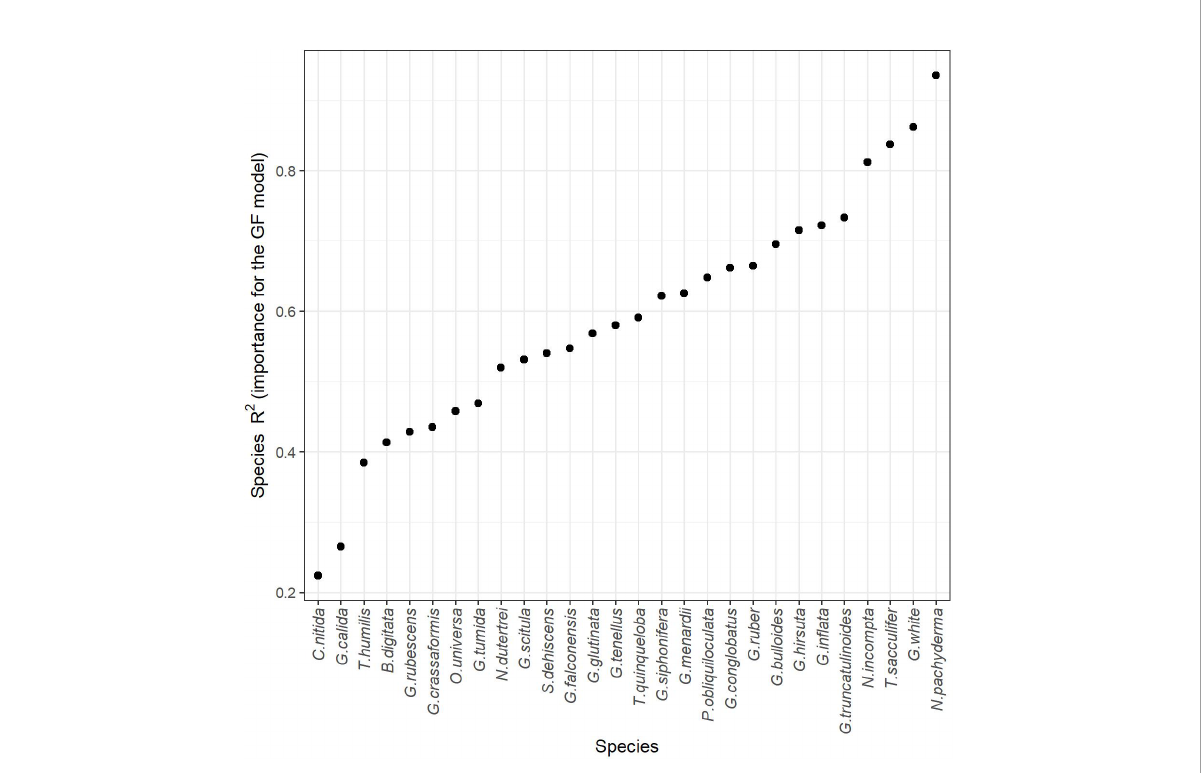
FIGURE 4 Importance of the foraminifera species (R 2 ) for the turnover on the Gradient Forest Analysis